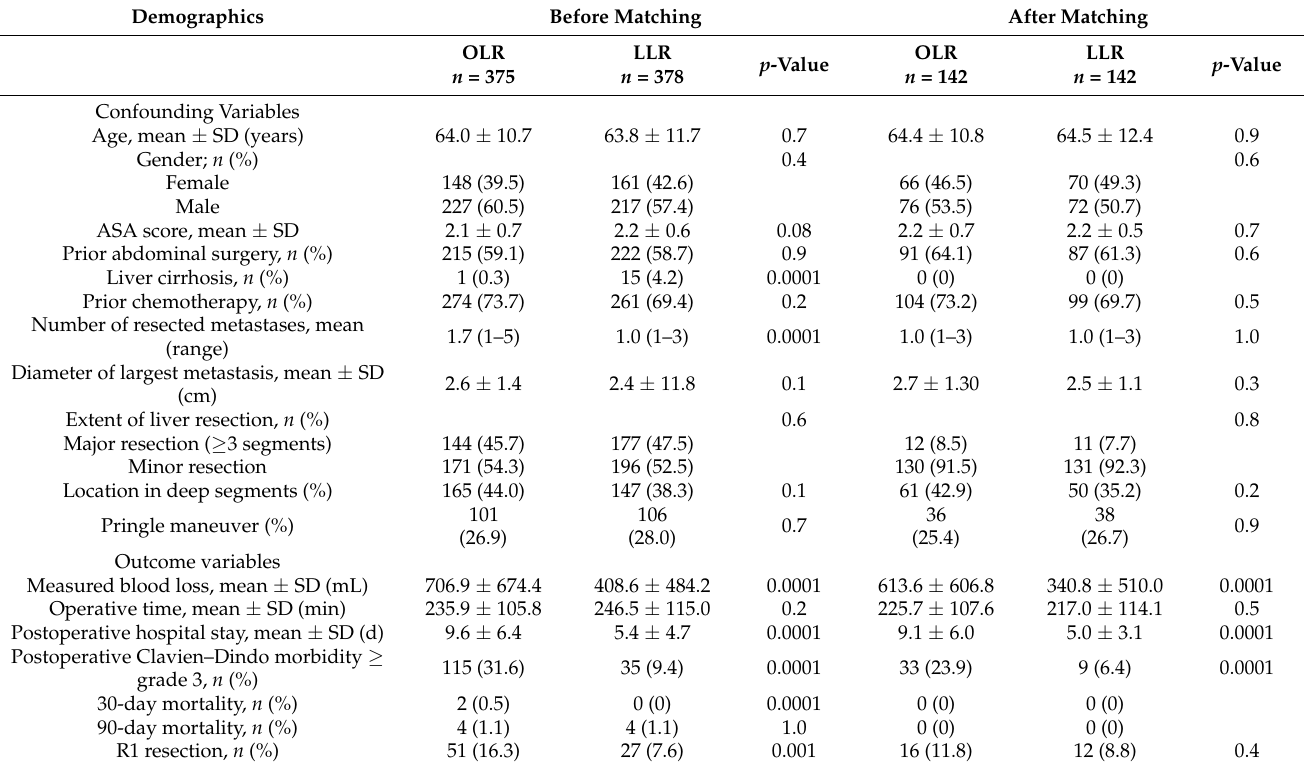
Table 2. Demographics/confounding variables and clinical outcome variables of patients receiving open (OLR) or laparoscopic liver resection (LLR) for colorectal liver metastasis before and after propensity score